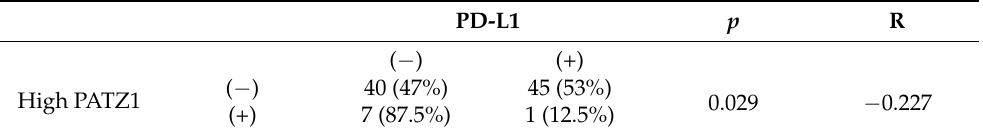
Table 6. Contingency table showing the correlation between High PATZ1 and PD-L1 1